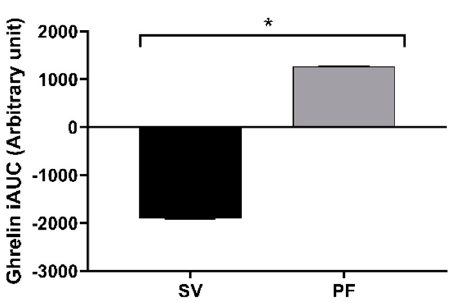
Figure 4. The baseline adjusted area under the curve (iAUC 0-240 ) of the circulatory active ghrelin hormone in response to the two treatment arms, PF: pan-fried and SV: sous-vide. The values are presented as mean ± SEM. Comparisons between the two cooking methods were conducted using a paired t -test. * The values differed significantly between the cooking methods ( p = 0.006).